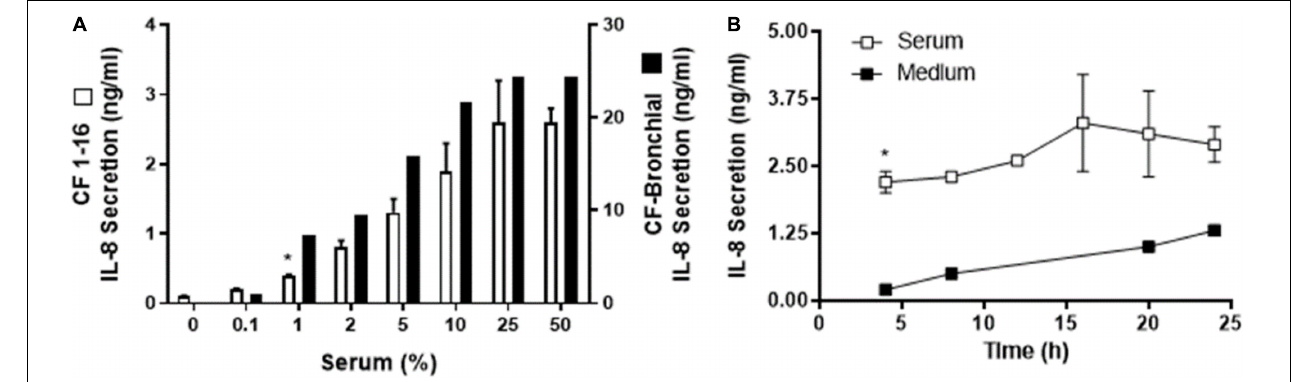
FIGURE 2 | Human serum induced IL-8 secretion from a cystic fibrosis (CF) epithelial cell line. (A) Immortalized CF nasal epithelial cell line (CF 1–16) (open bars, n = 3) and CF bronchial epithelial cells (black bars, n = 2) were incubated for 6 h with increasing percentages of human serum, and IL-8 secretion was measured. Human serum induced a dose-dependent IL-8 secretion in both CF cell line and the CF bronchial cells. (A) * indicates the lowest % of serum capable of producing a significant increase in IL-8 production. CF bronchial epithelial cells’ response to serum to produce IL-8 secretion is almost one order of magnitude higher compared to the cystic fibrosis epithelial cell line. (B) CF 1–16 cells were incubated with 5% of single-donor serum ( (cid:3) , n = 3) or medium ( (cid:4) , n = 2), and IL-8 secretion ( n = 3–4) was determined at 4, 8, 12, 16, 20, and 24 h. At 4 h of incubation, human serum induced a significant increase in IL-8 secretion compared to the control group. (B) * indicates a statistically significant ( p < 0.05) increase in IL-8 secretion after 4 h of incubation with serum compared to the control group. No significant changes were observed for IL-8 secretion after longer period of incubation.